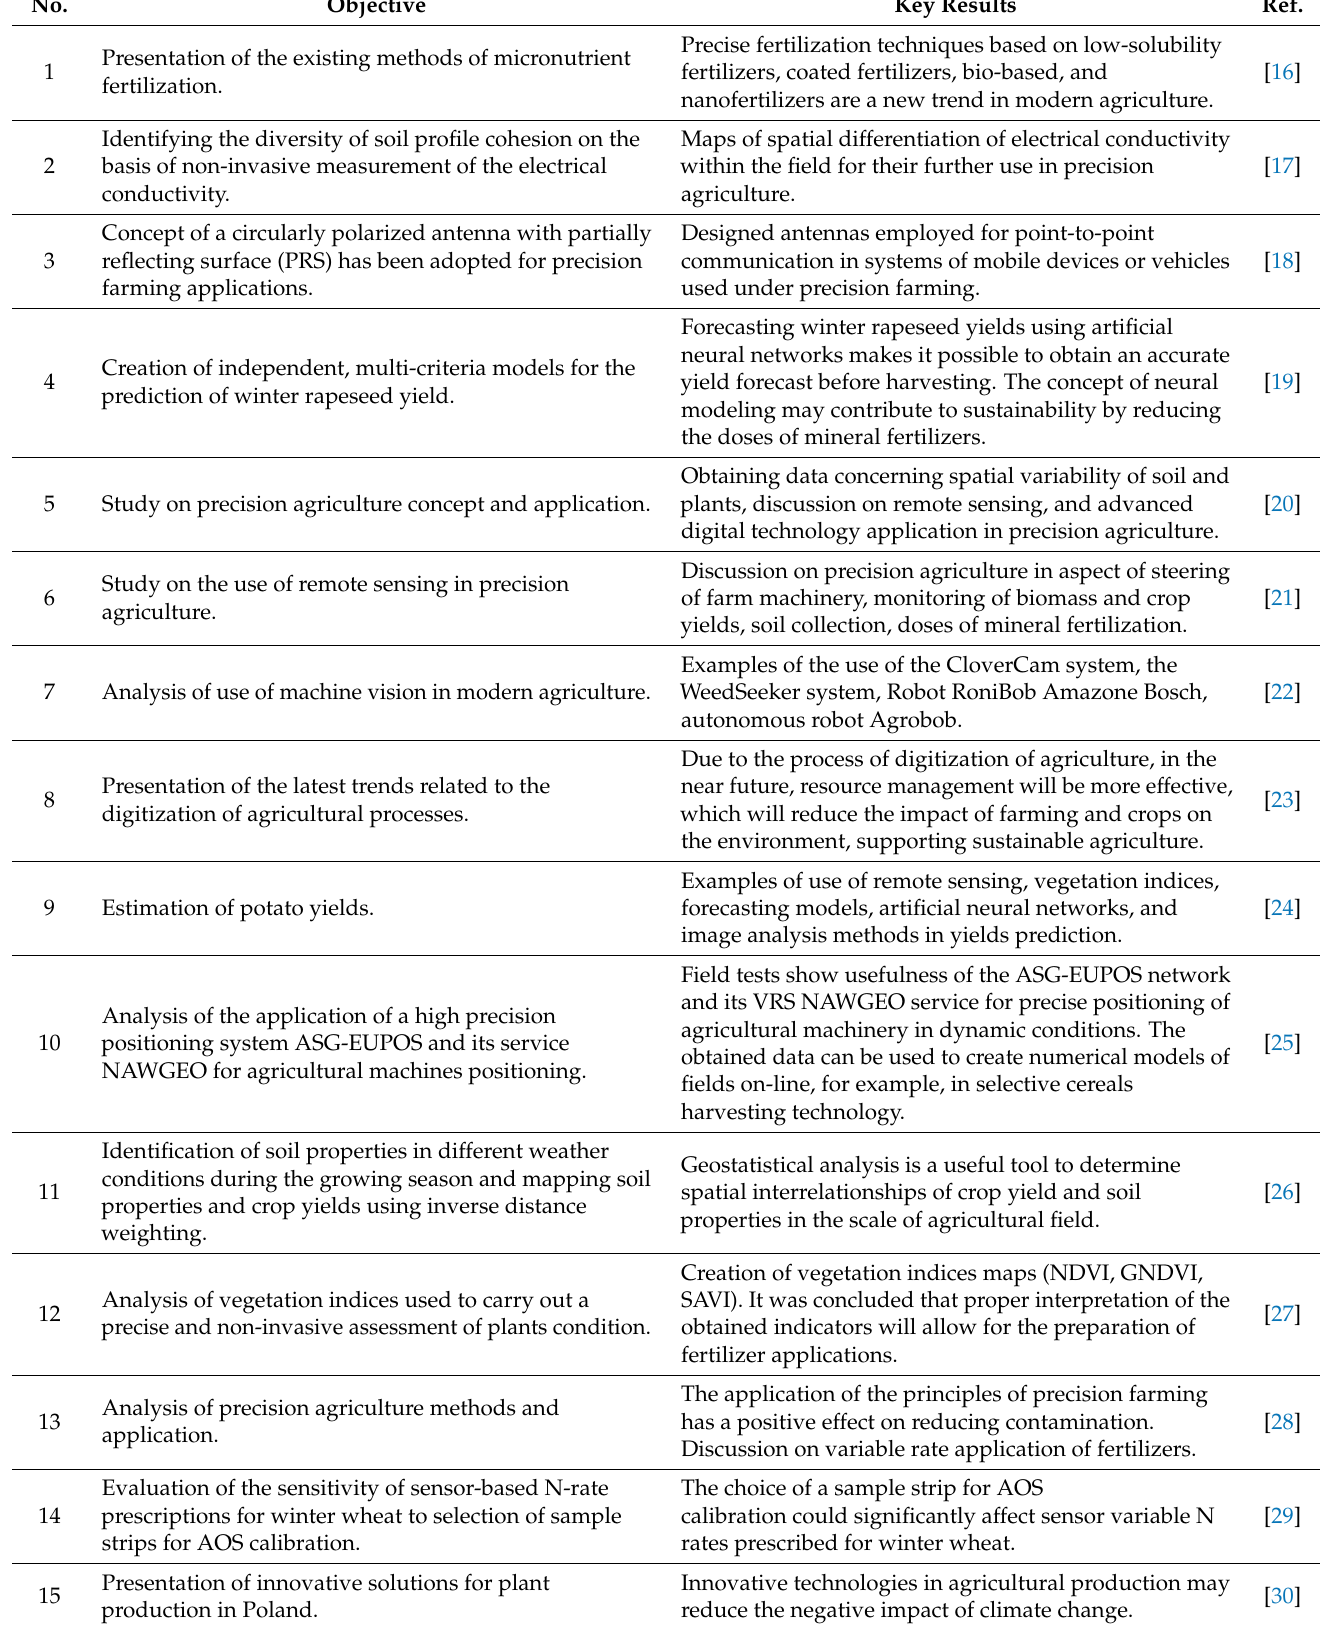
Table 1. Summary of selected precision agriculture research carried out in Poland in